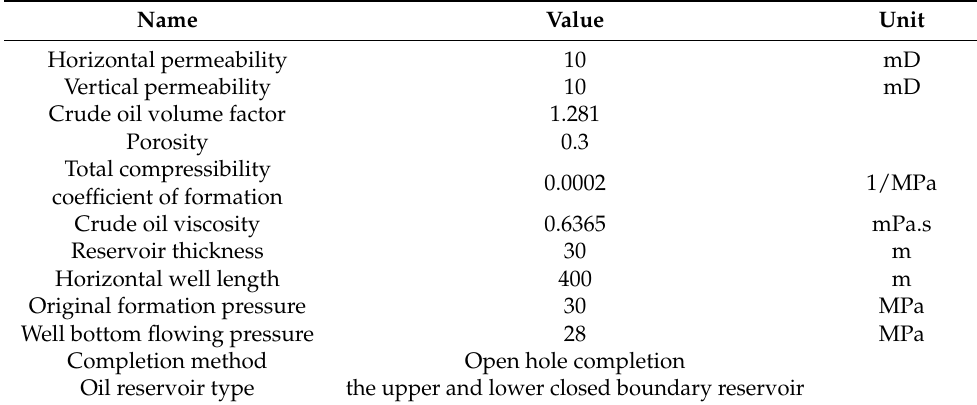
Table 3. Production prediction with constant bottom hole flowing pressure.